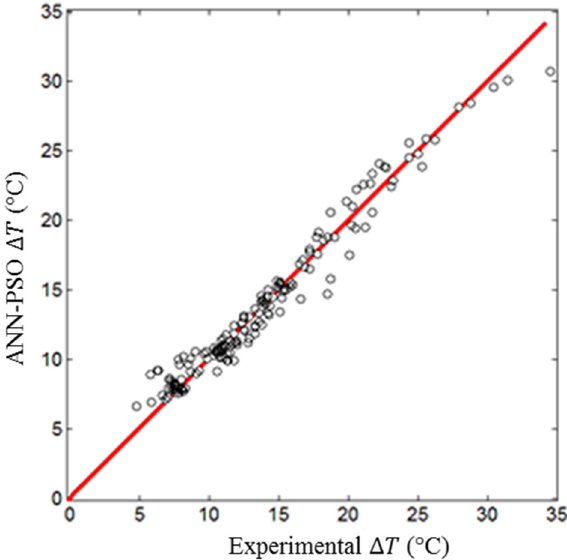
Figure 12. Estimated temperature difference by ANN-PSO based on experimental data (training stage).